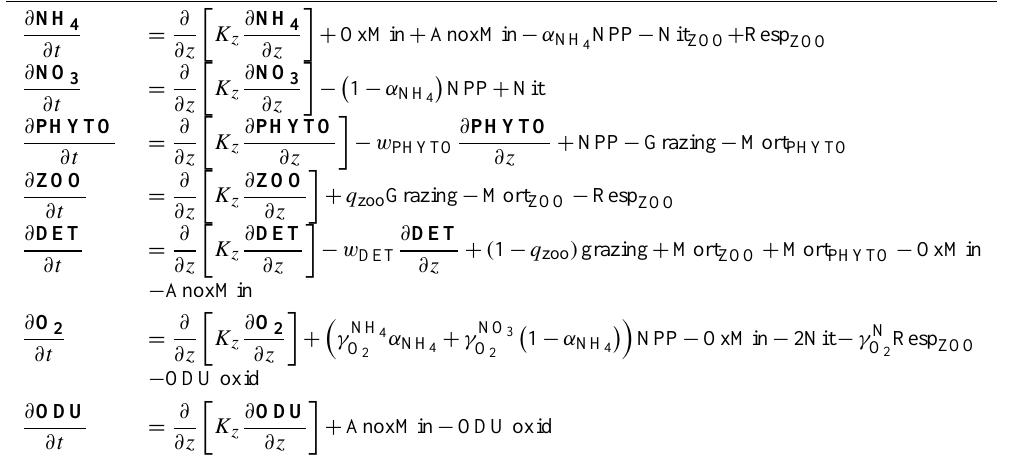
Table 5. Mass balance equations of the pelagic ecosystem model. The state variables are in bold. The quantity z represents the depth in the water column. Oxic mineralization (OxMin), anoxic mineralization (AnoxMin), net primary production (NPP), NH 4 fraction taken up in